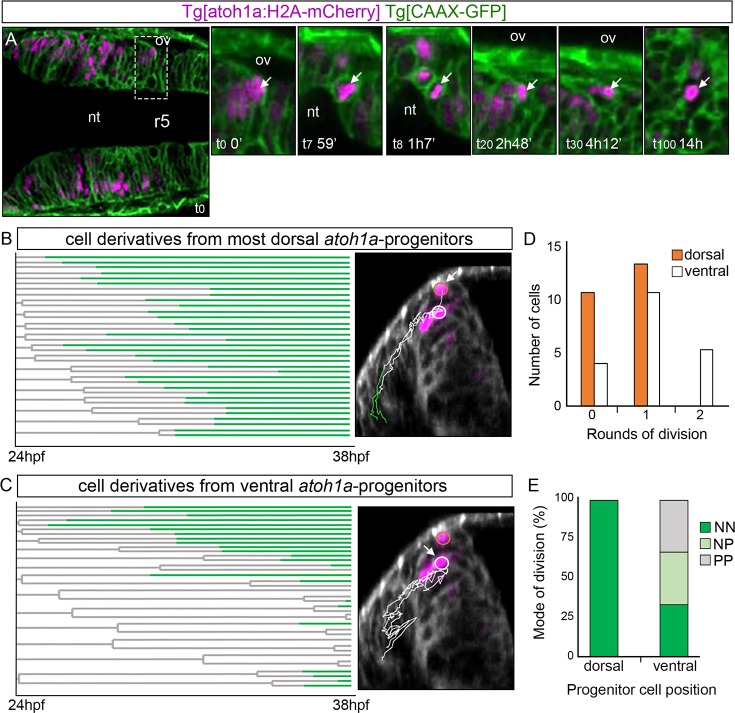
Cell lineages and behavior of atoh1a-derivatives.Tg[atoh1a:H2A-mCherry] Tg[CAAX:GFP] embryos were imaged from 24hpf during 14h, and information about cell position was acquired every 7min. A) Dorsal view of an embryonic hindbrain displaying atoh1a cells in magenta with anterior to the left. The inserts display magnified stills from the framed area in (A) at different times (see white arrow as example of a cell that was tracked from t0 to t100). Note the cell nucleus displacement towards the apical side before division (t8). B-C) Cell lineages from r4 and r5 atoh1a-progenitors located at different dorsoventral levels within the atoh1a domain; n = 22 in (B) and n = 17 in (C). Each line corresponds to a single cell that branches upon division. Lines are colored according to cell differentiation status: progenitors in grey and differentiated cells in green. The X-axis corresponds to developmental time. The right-hand images display examples of the trajectories of the atoh1a tracked cells (white arrow) on the top of the transverse views at t0 (24hpf). Cell trajectories are color-coded according to cell differentiation status: progenitors are in white and differentiated cells in green. Cells are considered differentiated neurons when they are within the neuronal differentiation domain. Dorsal most atoh1a cells are encircled in orange and ventral atoh1a cells are encircled in white. D) Histogram displaying the number of most dorsal (orange) or ventral (white) atoh1a:GFP cells that undergo different number of divisions over time. Note that atoh1a-cells that are more dorsally located undergo less division rounds (orange bars) than the ones in a more ventral position (white bars). E) Mode of cell division according to the DV position of the atoh1a-progenitor cells. NN, progenitors giving rise to two neurons; NP, progenitors generating one neuron and one progenitor; PP, progenitor cells that give rise to two progenitors. Note that most dorsal atoh1a cells give rise to differentiated cells in all analyzed cases (n = 22 atoh1a progenitors), whereas atoh1a cells more ventrally located employ the three modes of division (n = 17 atoh1a progenitors). nt, lumen of the neural tube; ov, otic vesicle; r, rhombomere.